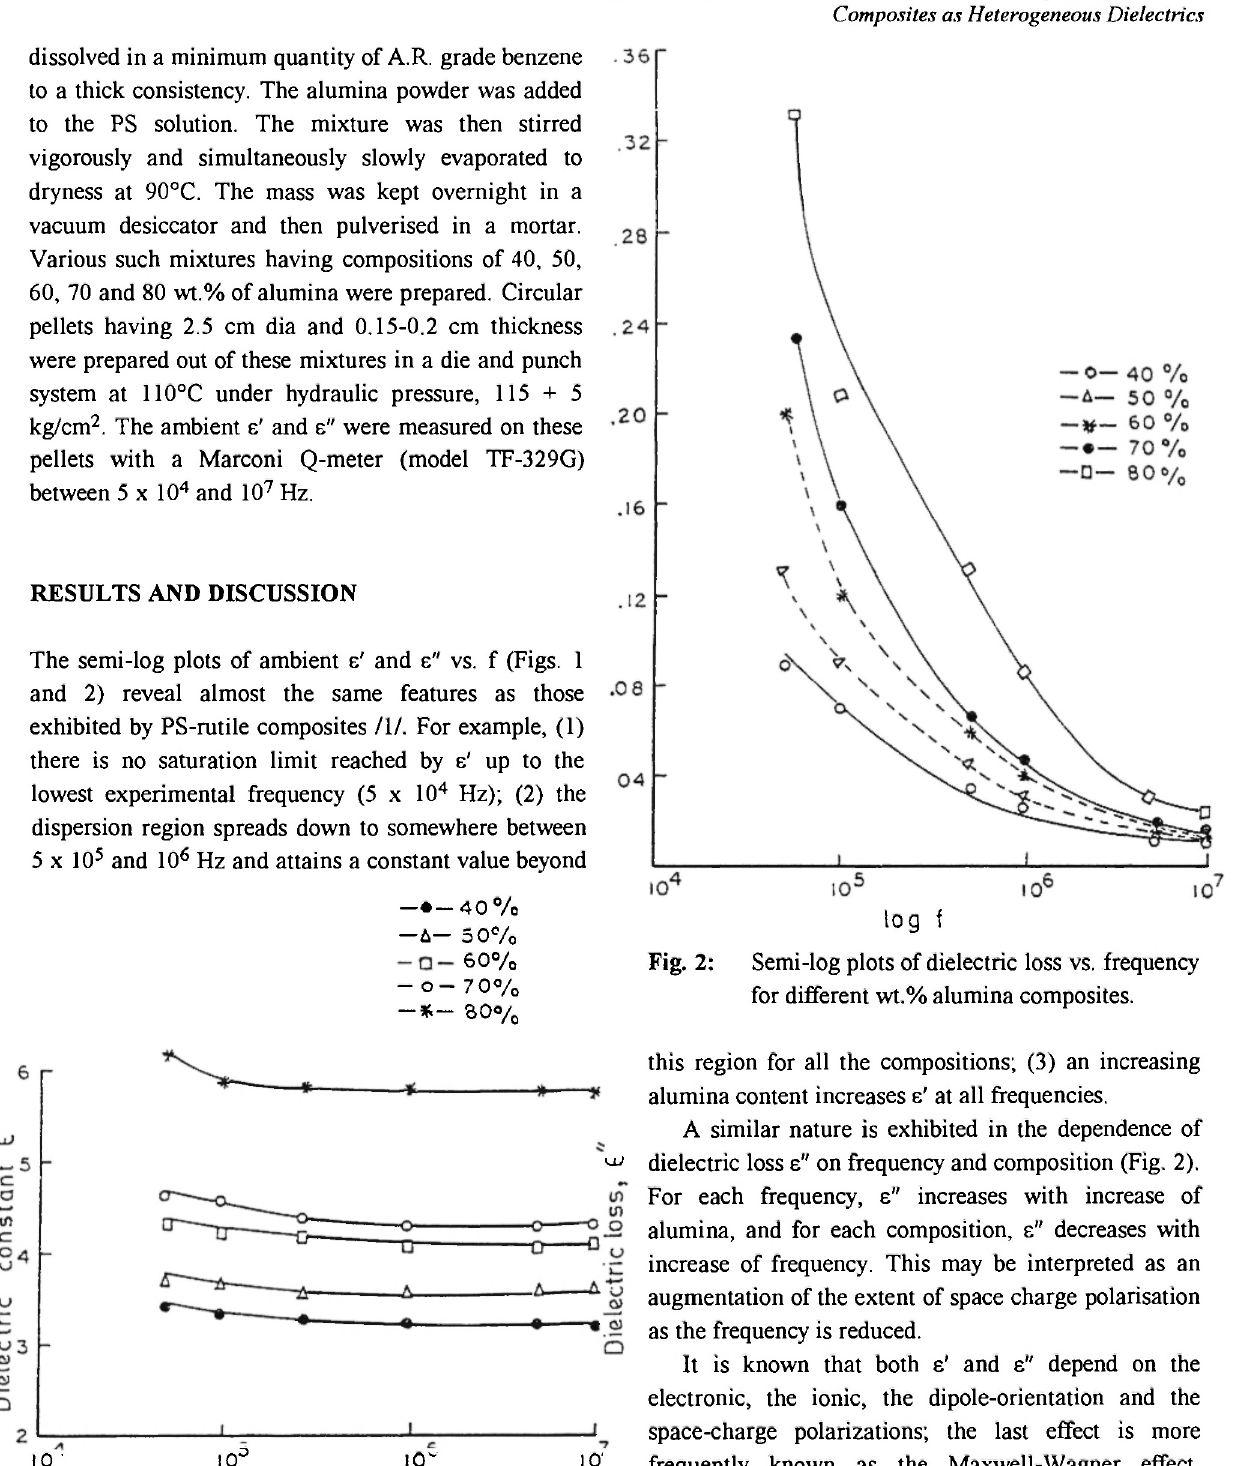
Fig. 1: Semi-log plots of dielectric constant vs. frequency for different wt.% alumina.